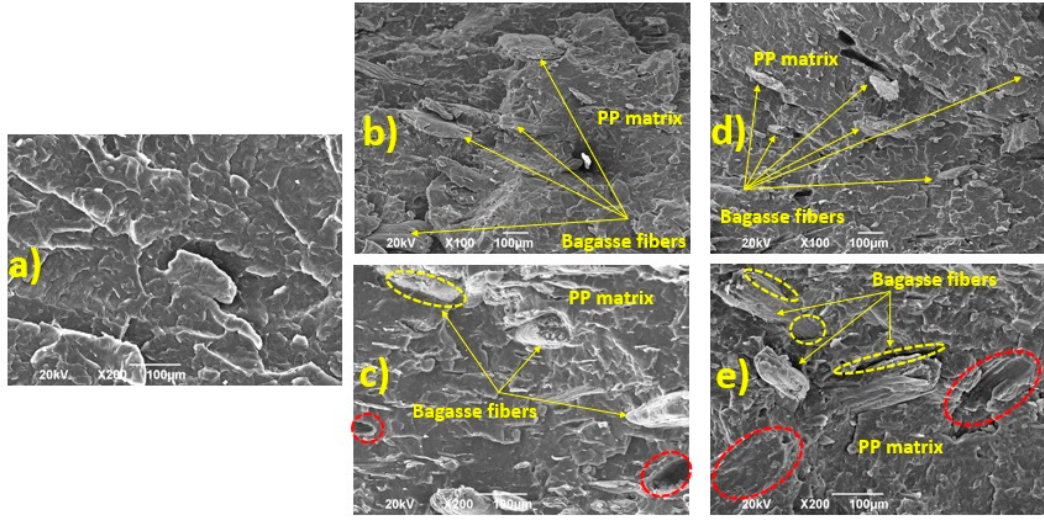
Figure 16. SEM micrograph of the fracture surface of ( a ) neat PP, ( b , c ) PP-Bag. 1st cycle and ( d , e ) PP-Bag. 5th